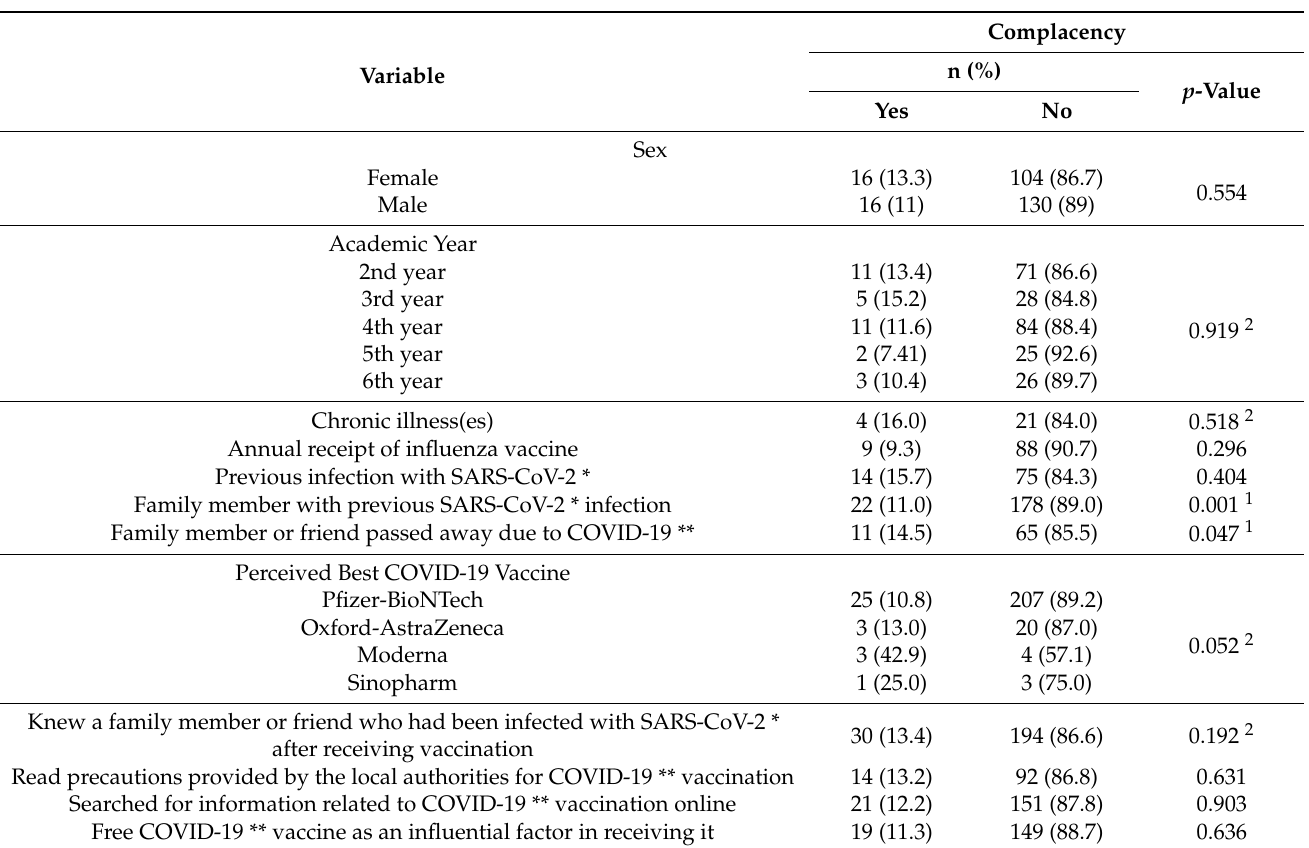
Table 4. Subgroup